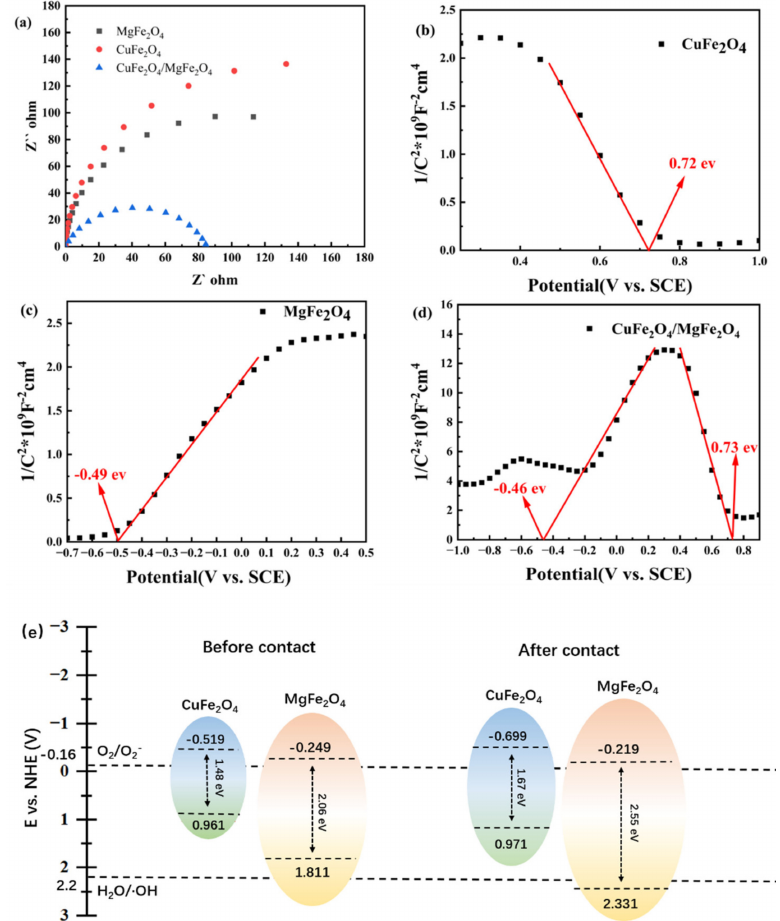
Figure 5. ( a ) EIS curves of the CuFe 2 O 4 , MgFe 2 O 4 and CuFe 2 O 4 /MgFe 2 O 4 composites; ( b – d ) Mott– Schottky plots of CuFe 2 O 4 , MgFe 2 O 4 and CuFe 2 O 4 /MgFe 2 O 4 ; ( e ) interfacial energy band diagram of the CuFe 2 O 4 /MgFe 2 O 4